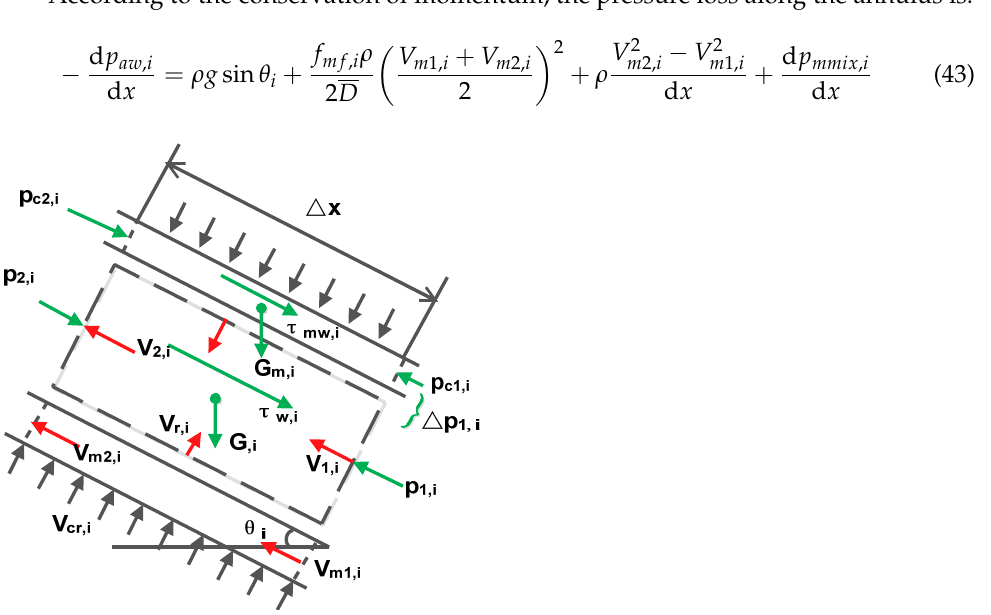
Figure 4. Force analysis of the i -th micro-element segment.